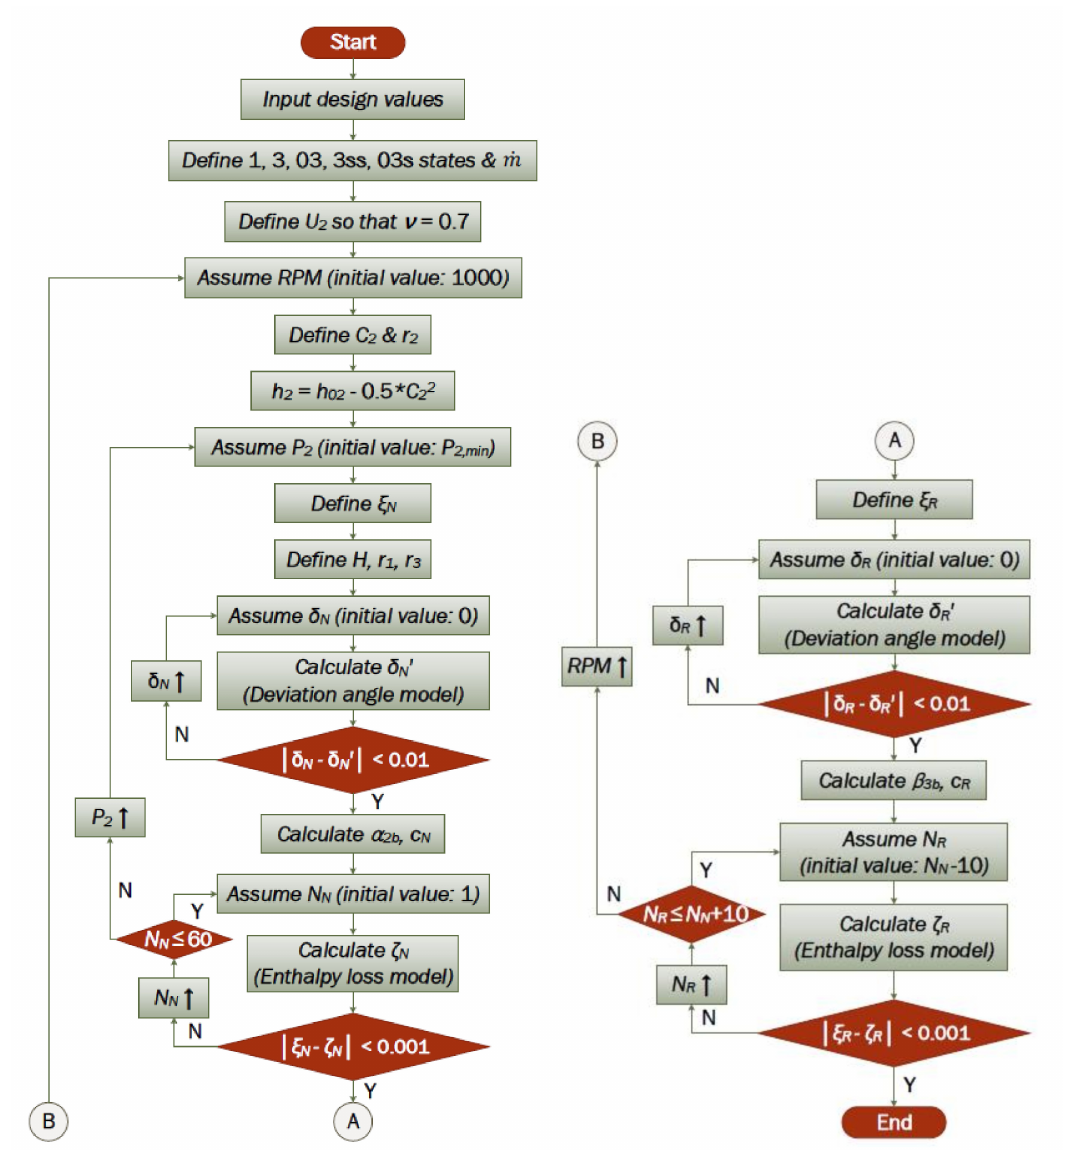
Figure 4. Flow chart of preliminary design program for a radial outflow